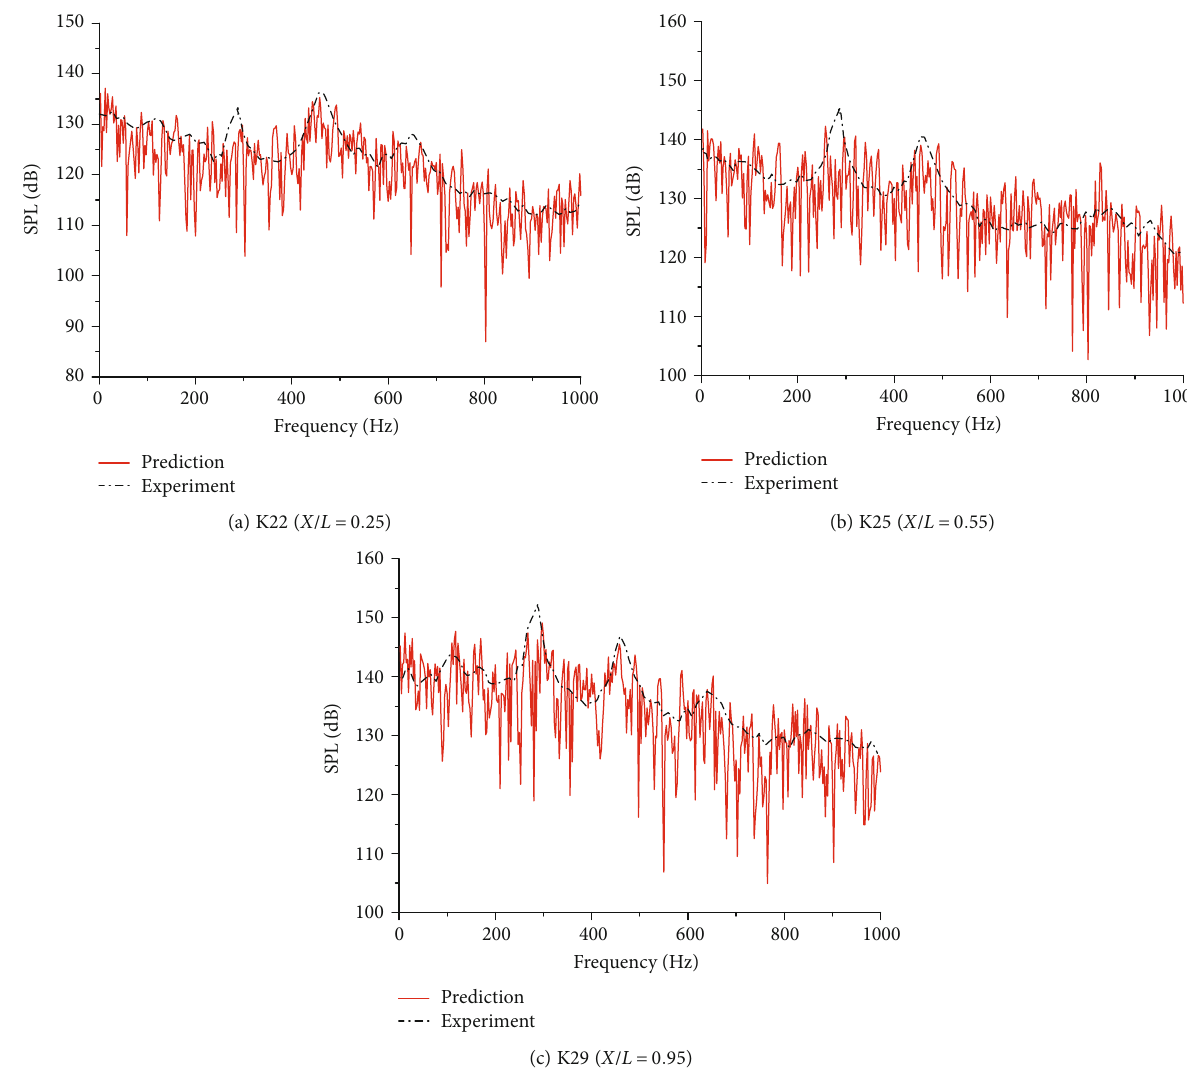
Figure 6: Comparison of spectrum between calculation and test at Ma = 0 : 6